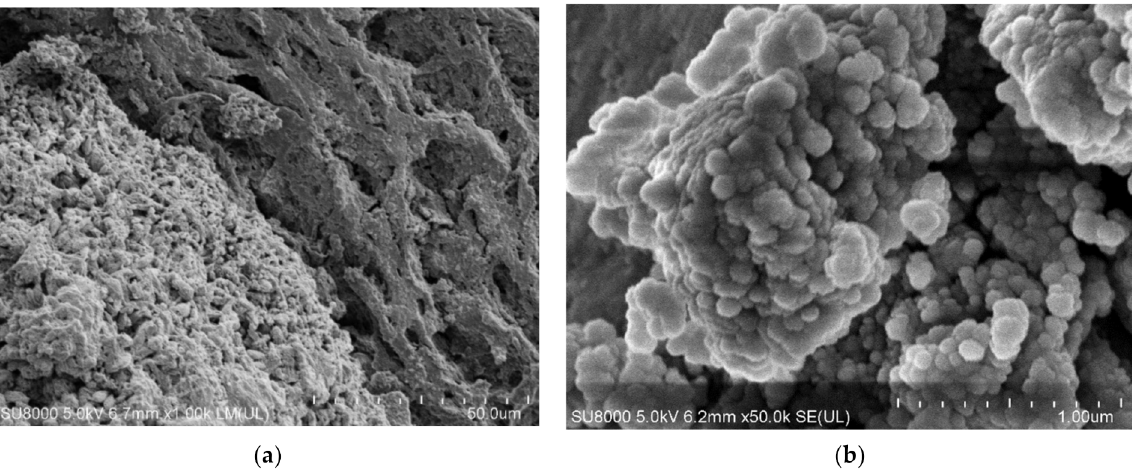
Figure 20. SEM images of: ( a ) Membrane surface covered by deposit precipitated from OWW2 wastewater; ( b ) Deposit layer magnify × 50 k. Module